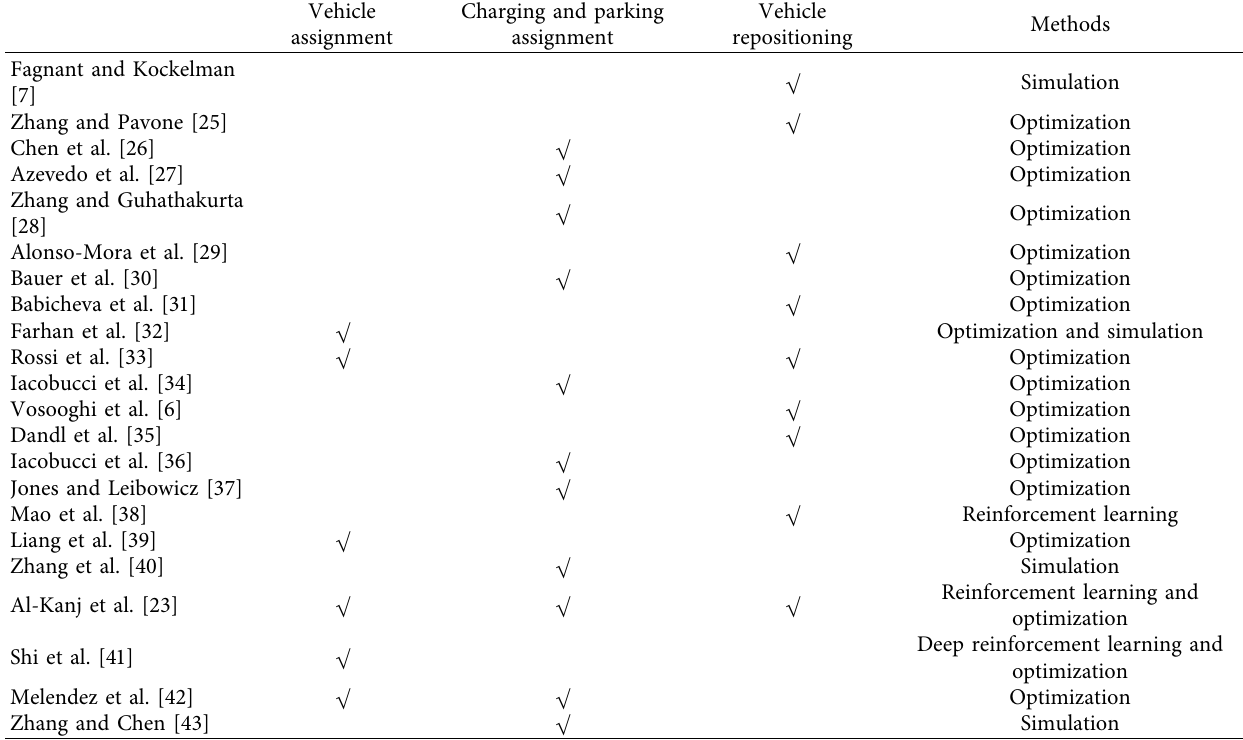
Table 1: Summary of literature